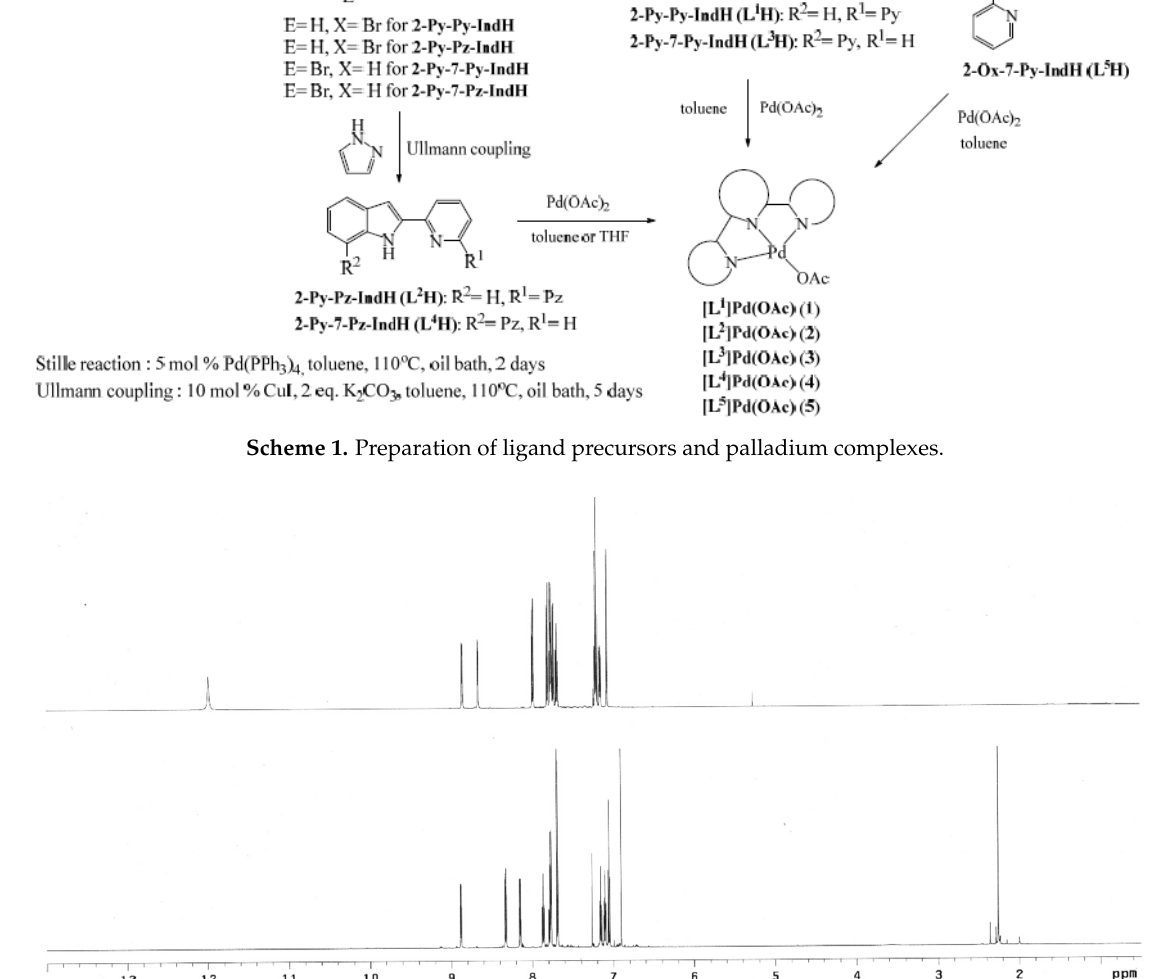
Figure 1. 1 H NMR spectra for L 3 H (upper) and [L 3